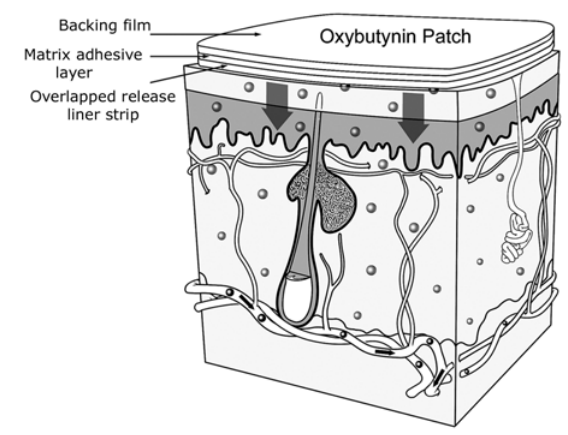
Figure 1 – Transdermal oxybutynin